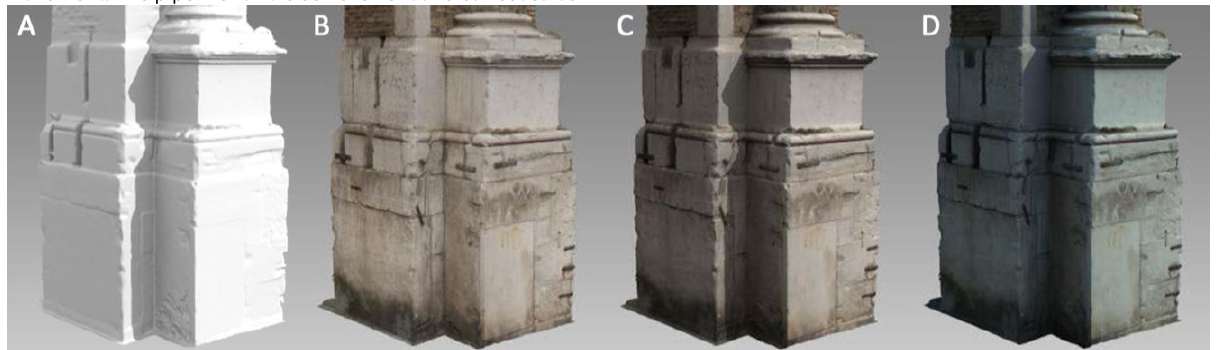
Figure 8. Detail of Porta Sisi: A) mesh shading (direct and indirect illumination); B) apparent colour used as luminous texture; C) and D) “double shadowed” model rendered under different lighting